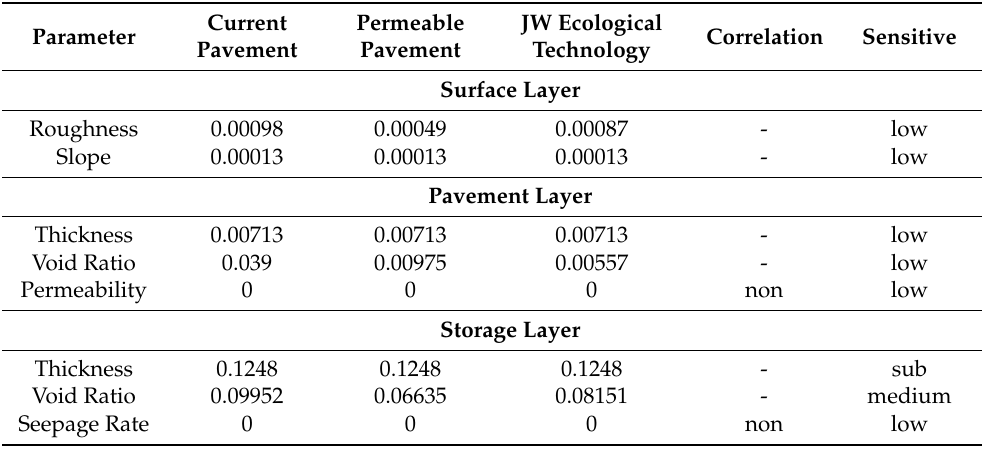
Table 4. SN value and sensitivity analysis of the stormwater management model permeable pavement parameters to outflow volume.